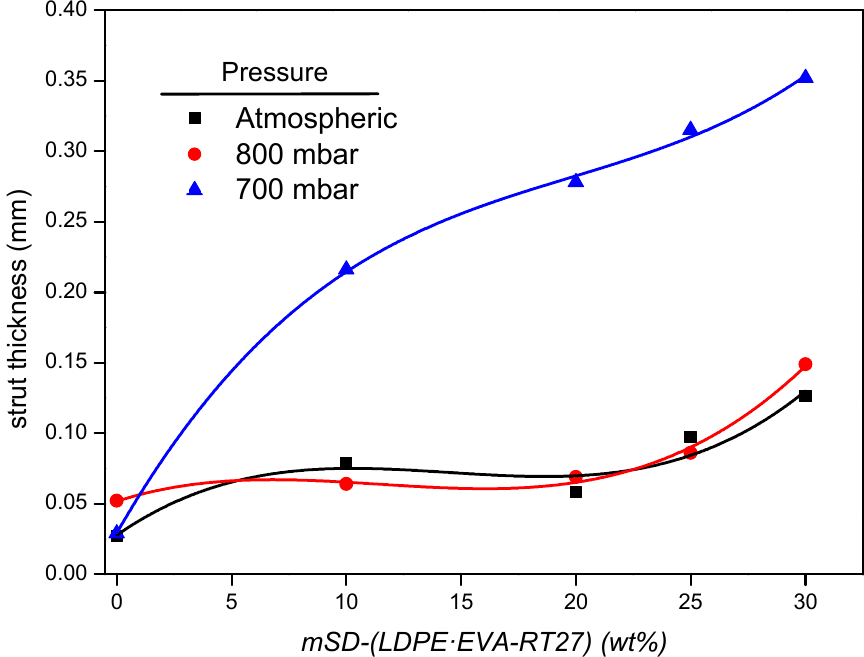
Figure 8. Strut thickness of the obtained foams for the different operational pressures.